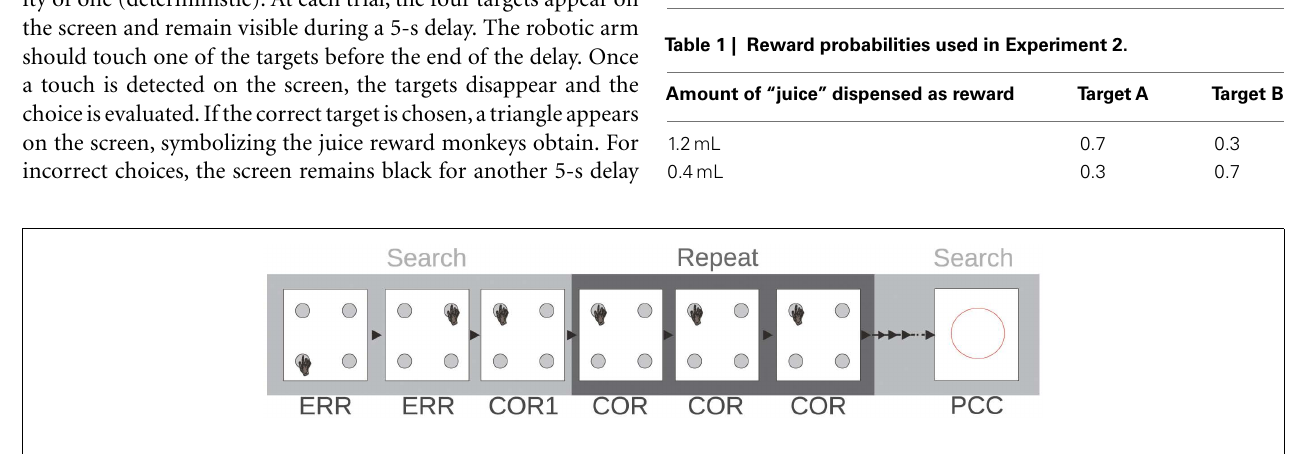
FIGURE 2 |Task used in Experiment 1. Four targets appear on the screen. Only one is associated with reward.The robot searches for the correct target.When the correct target is found, three repetitions of the correct choice are required before a problem-changing cue (PCC) appears. ERR, error; COR1, first correct trial; COR, subsequent correct